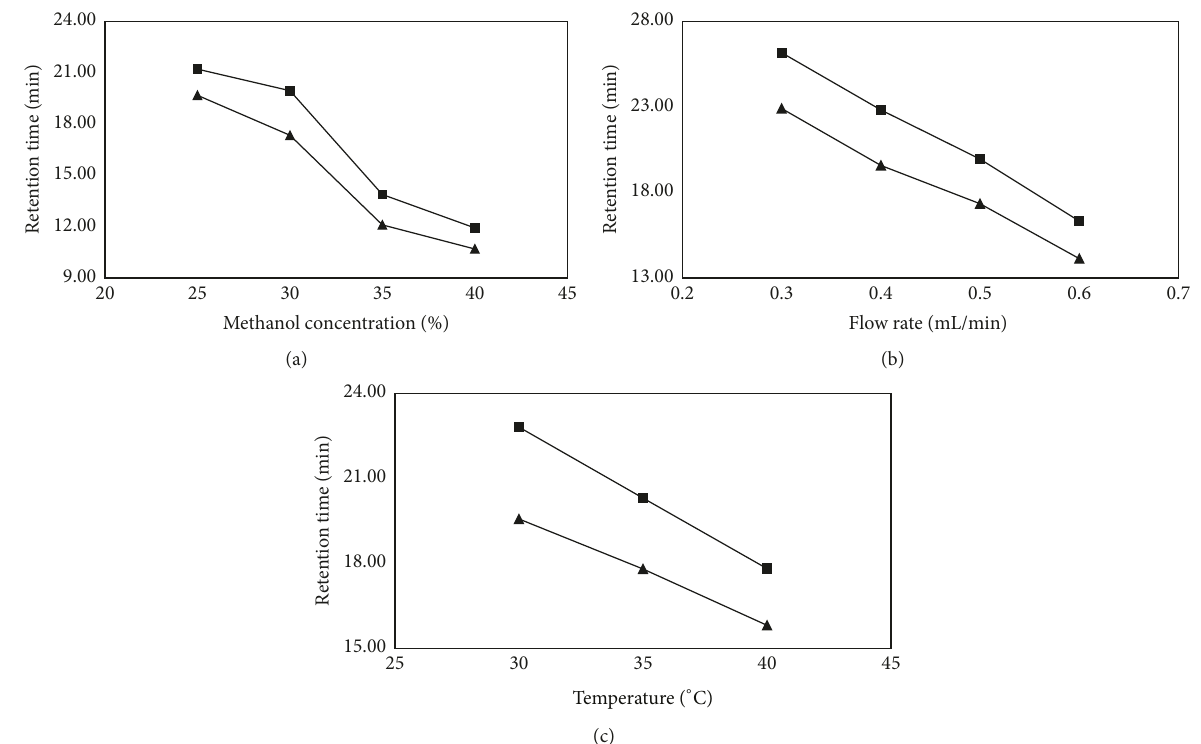
Figure 3: Effect of (a) methanol concentration, (b) flow rate, and (c) column temperature on the retention time of (R)-goitrin ( 󳵳 ) and (S)- goitrin ( ◼ ). Experimental conditions: S-Chiral A column (4.6 mm × 250 mm, 5 𝜇 m), methanol/water, 245 nm, and injection volume of 10 𝜇 L.